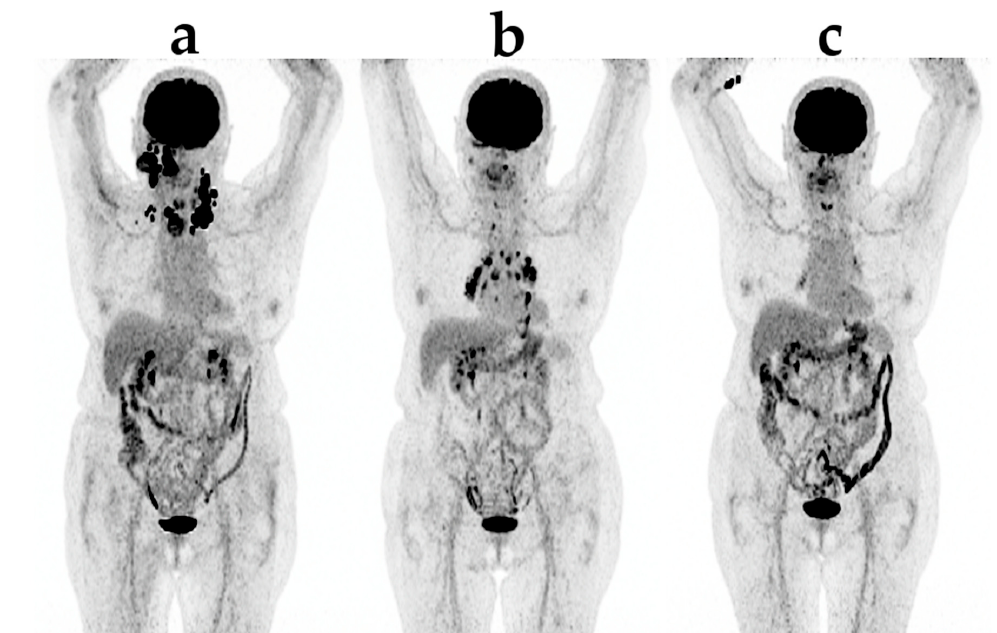
Figure 2. An example of new lesions appearing in an otherwise responding patient due to sarcoid-like irAE (immunerelated adverse event): ( a ) before treatment; ( b ) after three series of pembrolizumab; ( c ) after six series of pembrolizumab.